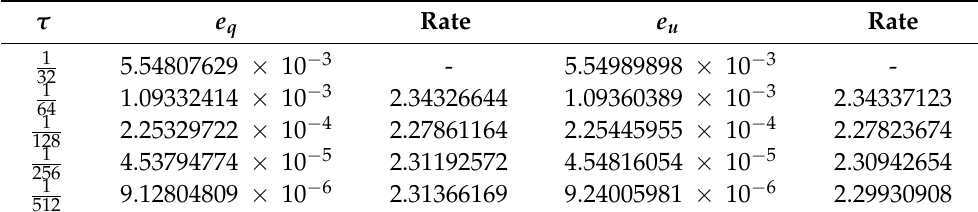
Table 6. Error e q and e u for the time convergence rates with α = 0.7.